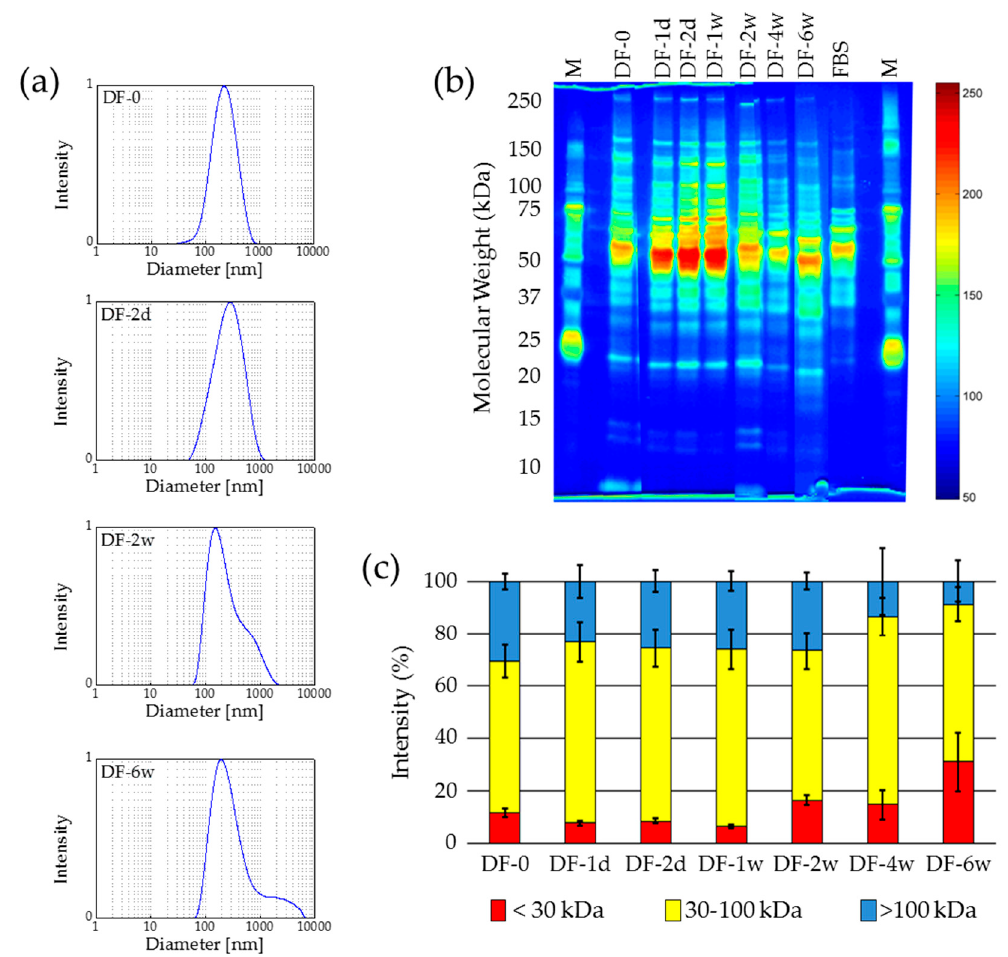
Figure 2. Deep-freezing of protein-coated nanoparticles at − 80 °C affects the integrity of the protein corona during long-term storage. ( a ) DLS measurements confirm the occurrence of larger agglomerates with extended storage times; ( b ) Protein size distribution is shifted towards smaller sizes after several weeks of storage demonstrated by gel electrophoresis (silver staining and false color representation); ( c ) Variations of the protein size ranges over the storage period (based on ( b )). n = 3, M—protein size marker.